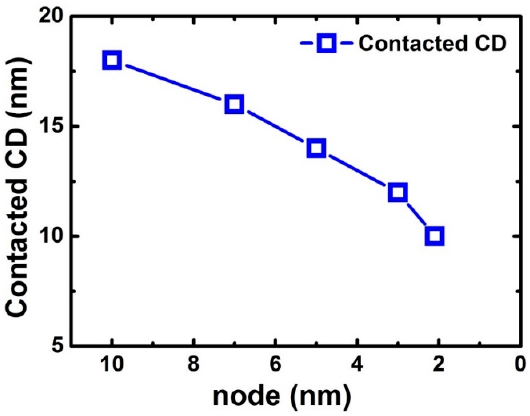
Figure 7. Values of contacted CD for advanced device.